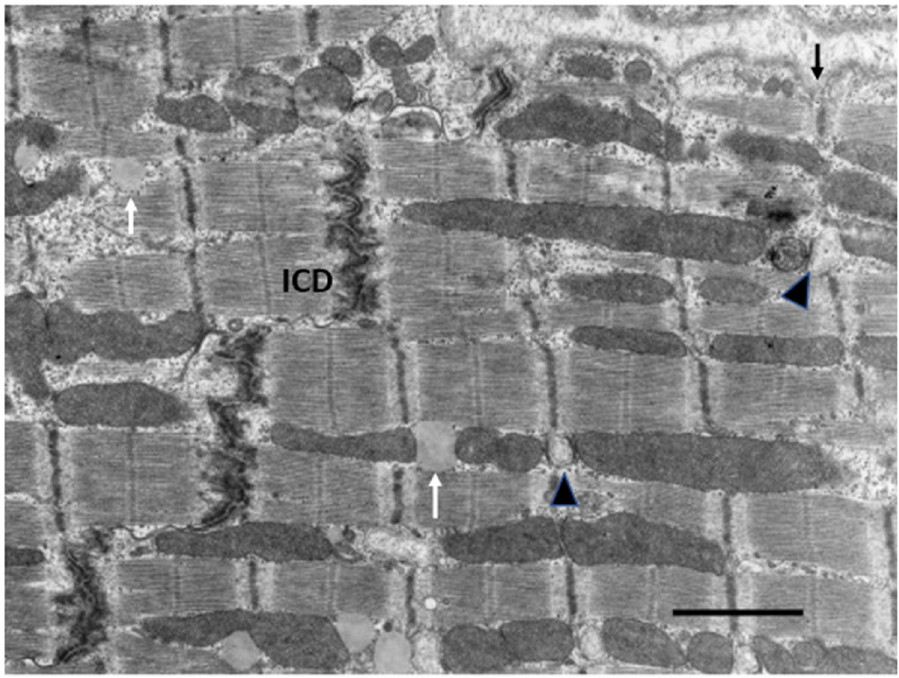
Figure 5. Electron micrograph of a normal adult rat. Note sarcomeres attached to intercalated disc (ICD) and sarcolemma at Z-band (arrow). Sarcoplasmic reticulum at Z-bands adjacent to mitochondria (arrowheads). Lipid (white arrow) Bar = 2 µm.